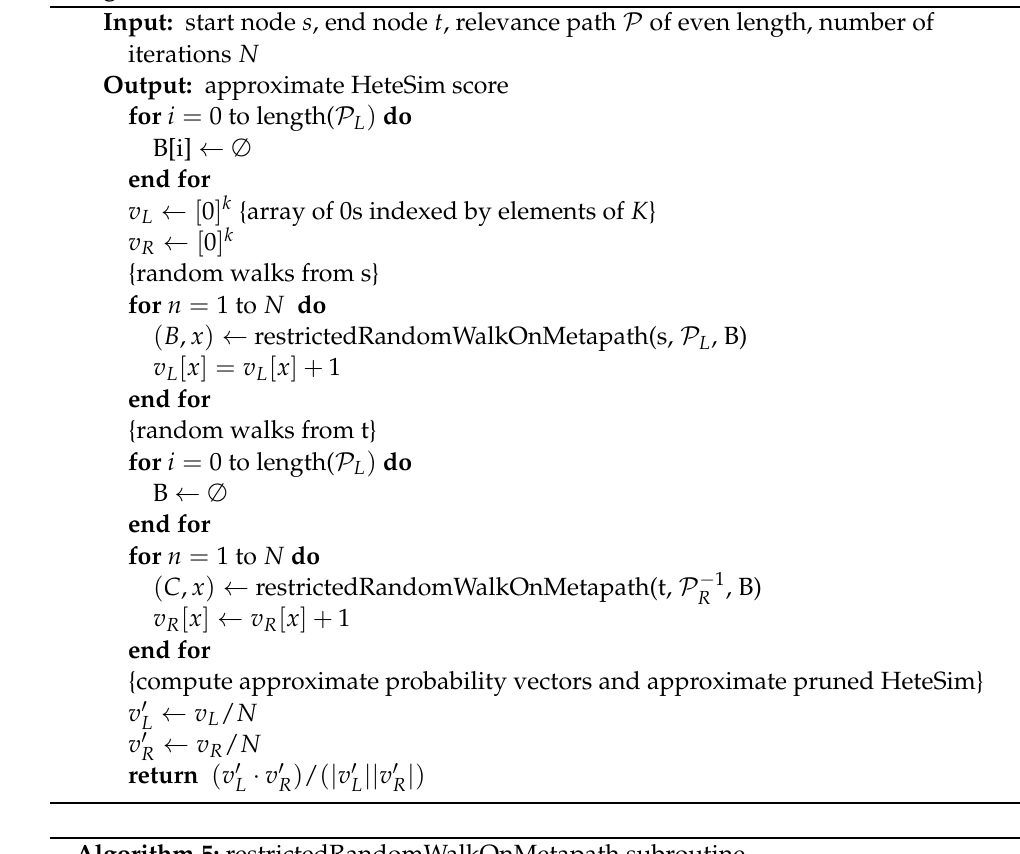
Algorithm 4: RandomizedPrunedHeteSimGivenN subroutine.